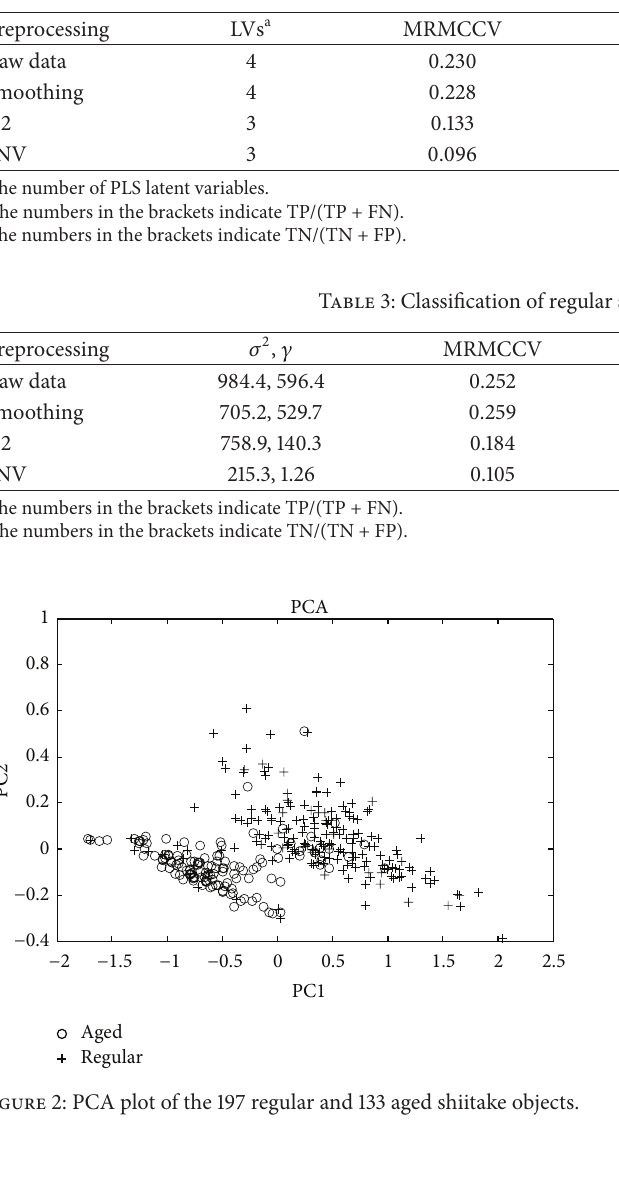
Table 2: Classification of regular and aged shiitake by PLSDA.